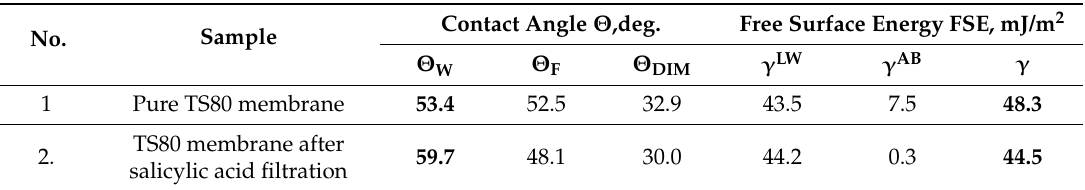
Table 6. Average values of contact angle for three standard liquids and free surface energy of pure TS80 membrane and membrane after salicylic acid